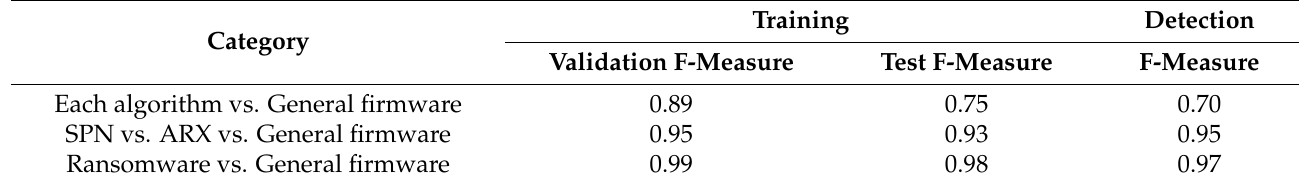
Table 5. Evaluation of instruction-based model.